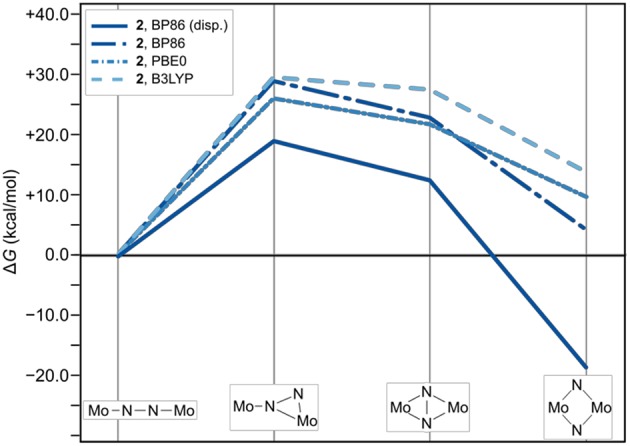
Effect of omitting dispersion corrections on the thermodynamic profile of the isomerization paths of 2. The thermodynamic profile including dispersion is shown as a solid line for reference; data points for which the electronic structures are calculated with BP are long-dashed-dotted (dark blue), with PBE0 are short-dash-dotted (mid-blue), and with B3LYP short-dashed (light blue).